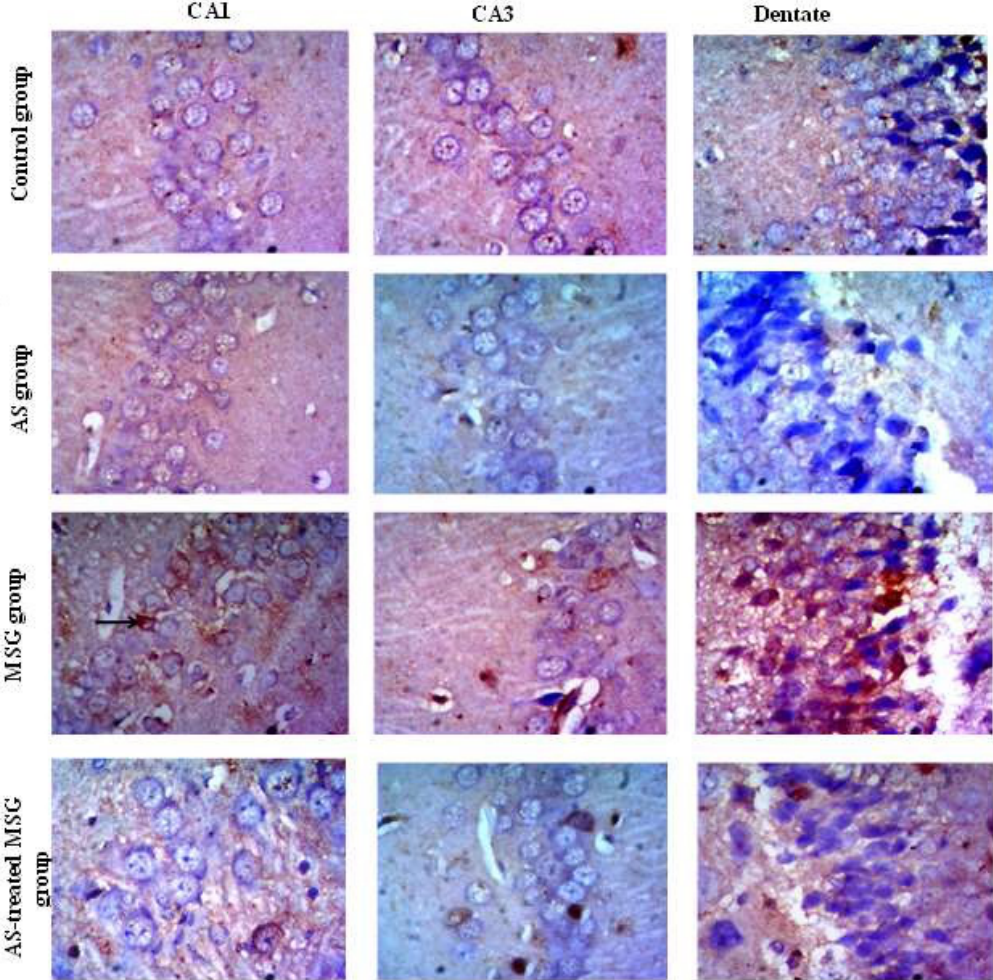
Figure 7. Light microscopic examination of caspase-3 stained sections of CA1, CA3, and dentate gyrus of the hippocampus. The figure shows weak cytoplasmic immune staining reaction in all areas in control and AS groups. The MSG group showed strong positive cytoplasmic immune staining reaction (arrows) in all areas, whereas the AS-treated MSG group showed moderate reaction (caspase-3 X400).